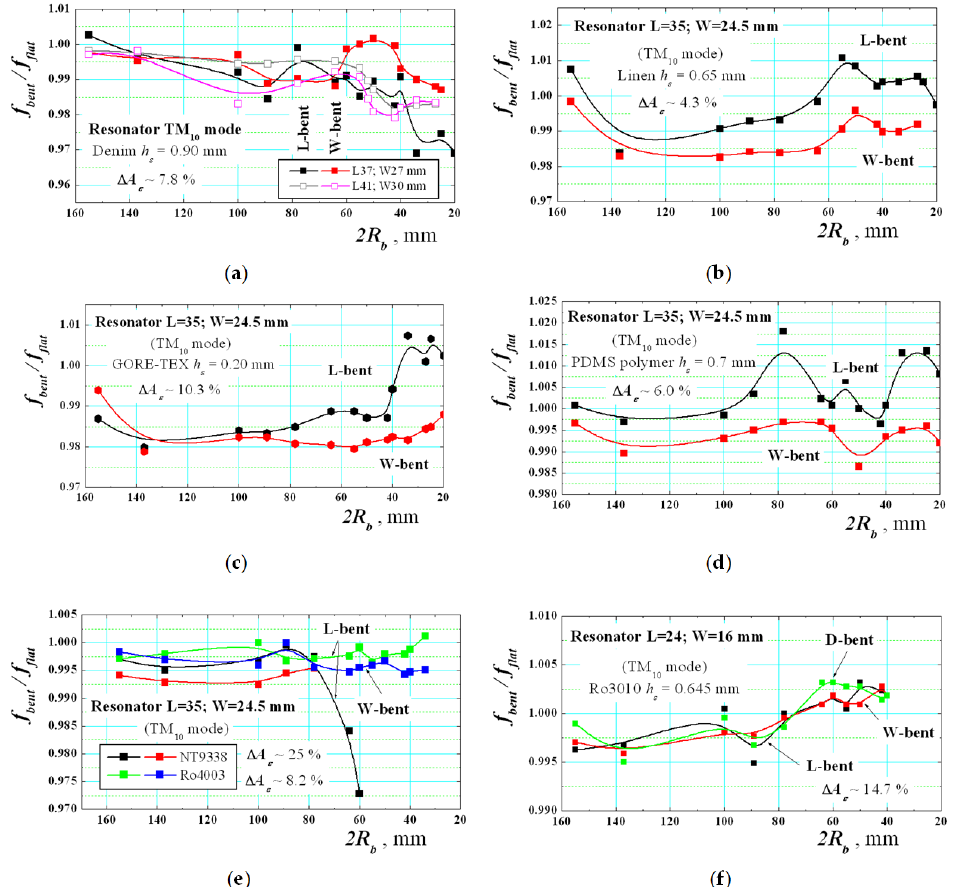
Figure 16. Experimental dependencies of the ratio between the resonance frequencies f bent / f flat of the lowest-order TM 10 mode for bent and flat rectangular resonators on several anisotropic substrates versus the bending radius R b : ( a ) Denim; ( b ) Linen; ( c ) commercial textile fabrics GORE-TEX ® ; ( d ) PDMS; ( e ) NT9338, Ro4003; ( f ) Ro3010.